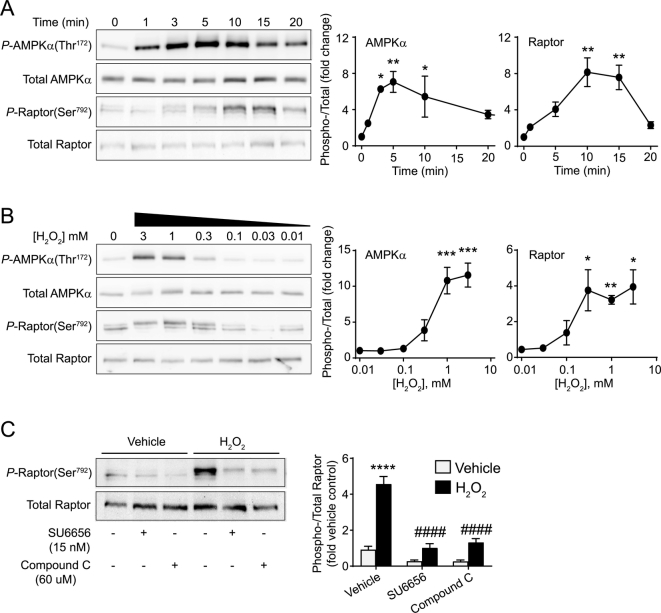
H2O2 activates AMPK and promotes AMPK-dependent phosphorylation of Raptor. Cardiomyocytes were exposed to 1 mM H2O2 for the times shown (A), to the concentrations of H2O2 indicated for 5 min (B), or were treated with SU6656 (15 nM) or compound C (60 μM) prior to addition of H2O2 (1 mM; 10 mins) (C). Samples were immunoblotted with antibodies to phosphorylated (P)-AMPKα(Thr172), total AMPKα, P-Raptor(Ser792) or total Raptor as indicated. Representative blots are shown in the left panels, with densitometric analysis and the ratio of Phospho−/Total proteins in the graphs on the right. (A) and (B), Results are means ± SEM (n = 4 independent myocyte preparations). *p < .05, **p < .01, ***p < .001 relative to unstimulated cells (one-way ANOVA with Dunnett's post-test). (C) Results are means ± SEM (n = 3 independent myocyte preparations). ****p < .0001 relative to unstimulated cells, #### p < .0001 relative to H2O2 alone (one-way ANOVA with Bonferroni post-test).